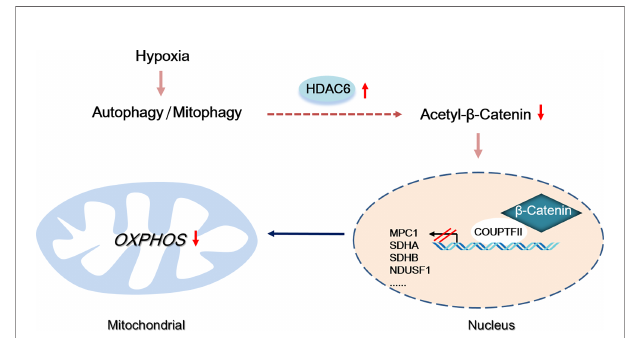
FIGURE 7 | Proposed model by which autophagy-induced HDAC6 inhibited mitochondrial OXPHOS through regulating b -Catenin acetylation